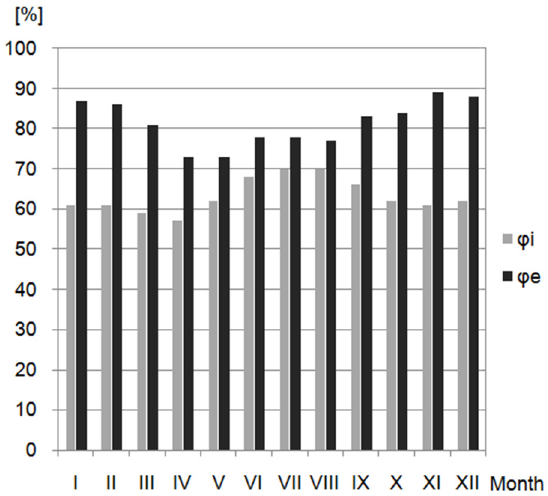
Figure 7. Indoor and outdoor relative humidity of air [42].